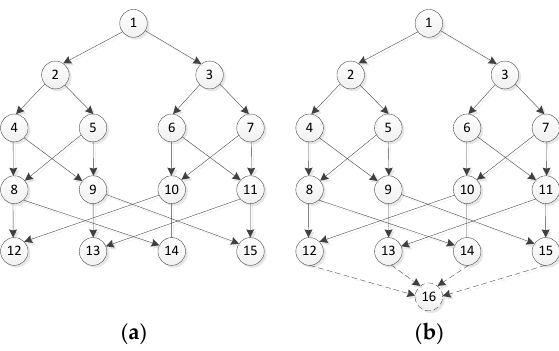
Figure 2. Fast Fourier transform (FFT) application model with 𝜌 = 4 : ( a ) original FFT application model; ( b ) FFT application model with a dummy exit task.